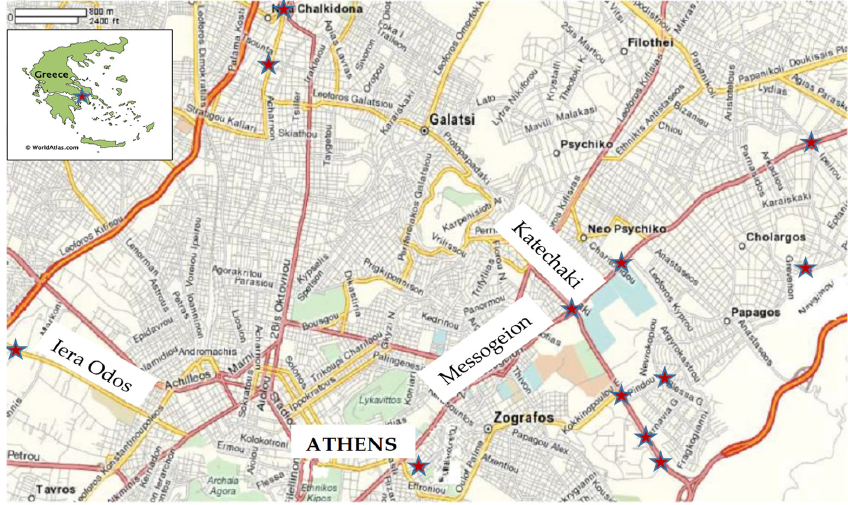
Figure 1. Map of Attica, showing the sites ( ) of sampling).